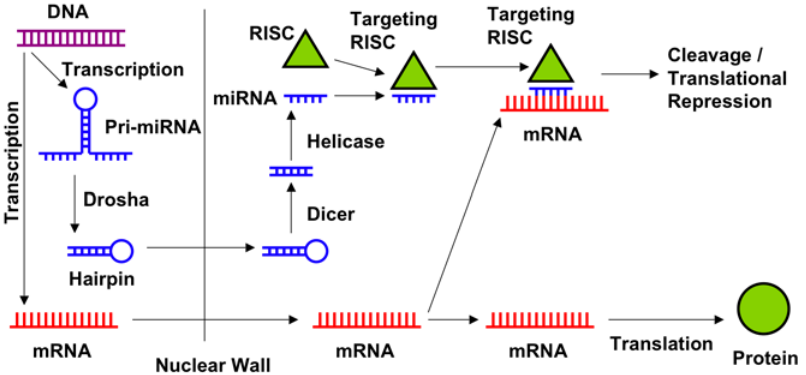
Figure 1. miRNA biogenesis and gene silencing. miRNA biogenesis begins with transcription of a pri-miRNA which is processed into a hairpin, exported from the nucleus, processed into a mature miRNA, and incorporated into a RISC. Minimal functional RISCs consist of an Argonaute protein and a miRNA. RISCs hybridize to mRNAs at targeting sites complementary with the miRNA, and prevent translation by either cleaving the mRNA or maintaining its position at the target site and stopping ribosomal activity.